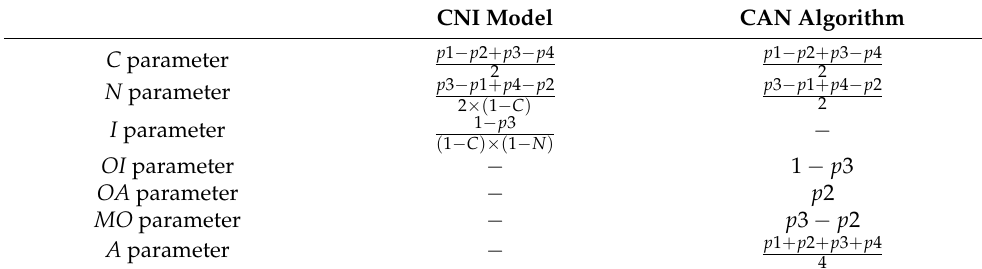
Table 1. Equation contrasts between the CNI model and the CAN